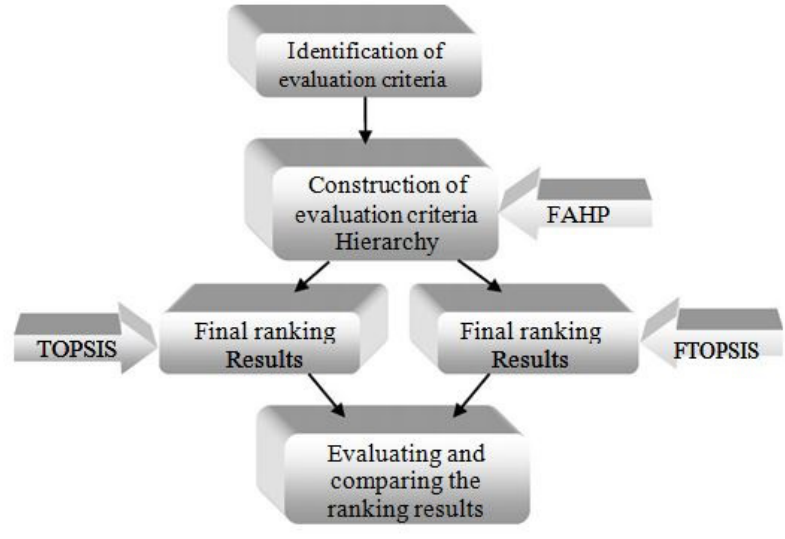
Fig.1. Steps of evaluation